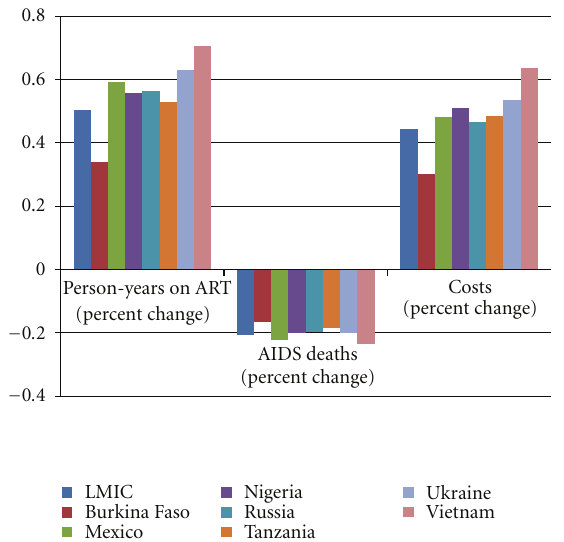
Figure 5: Comparison of results for changing eligibility criterion to CD4 count < 350 between LMIC and country-level calculations.